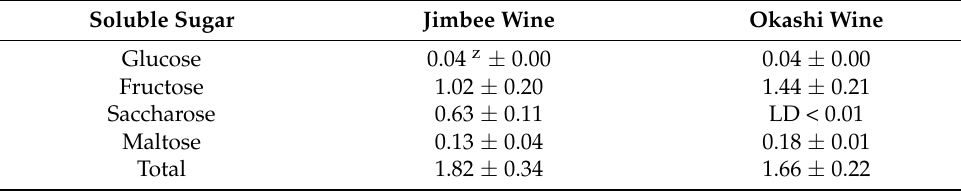
Table 4. Individual sugar (g/L) of the Jimbee and Okashi melon wines. Soluble Sugar Jimbee Wine Okashi Wine